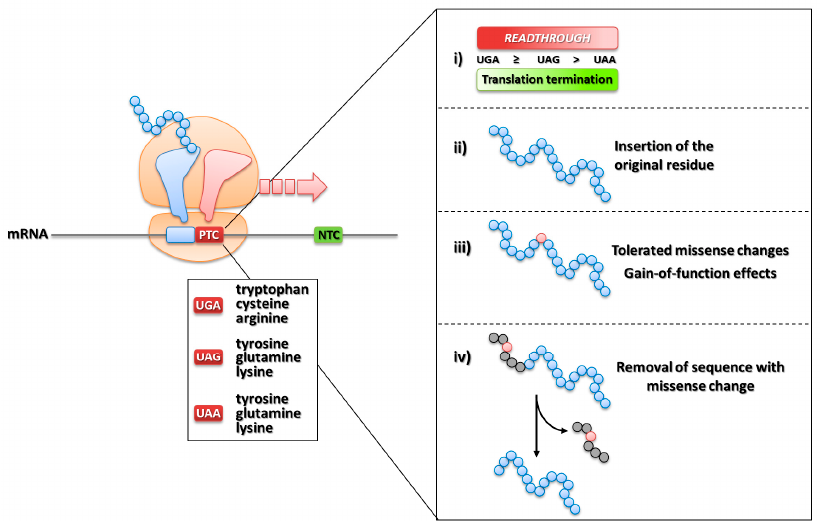
Figure 9. Amino acid insertions and productive protein outputs arising from readthrough. Type of amino acids inserted at PTCs as a function of the type of stop codon ( left panel) and molecular determinants influencing the productive output of readthrough ( right panel).